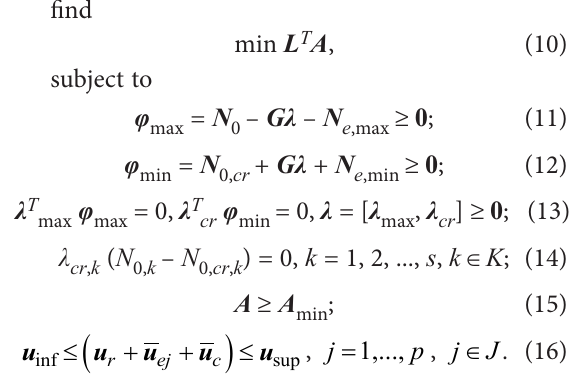
Calculation of buckling reduction factors